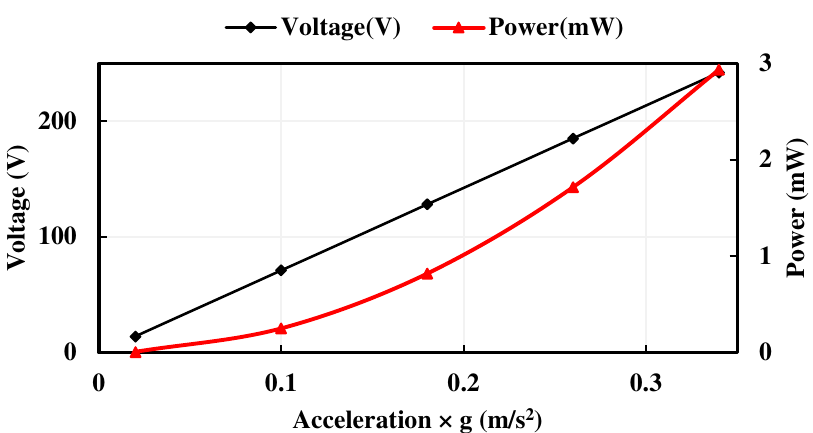
Figure 18. The acceleration dependence of power and voltage.